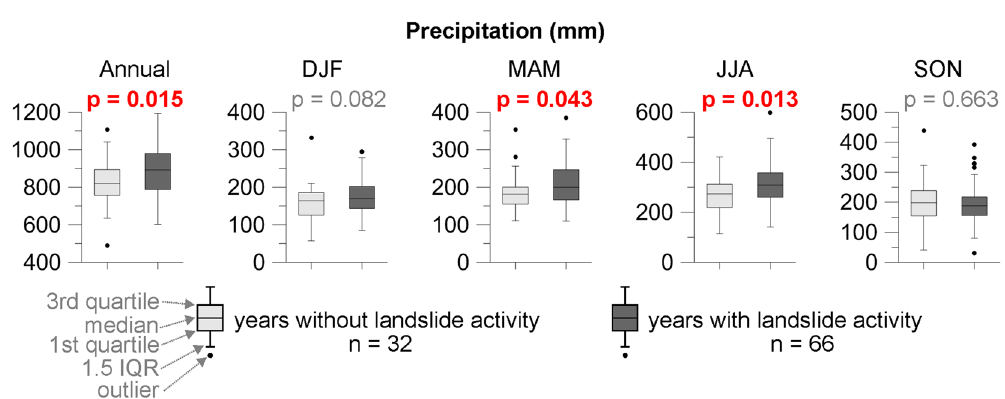
Figure 3. Comparison of years with and without the landslide activity based on annual and seasonal precipitation. IQR = Interquartile